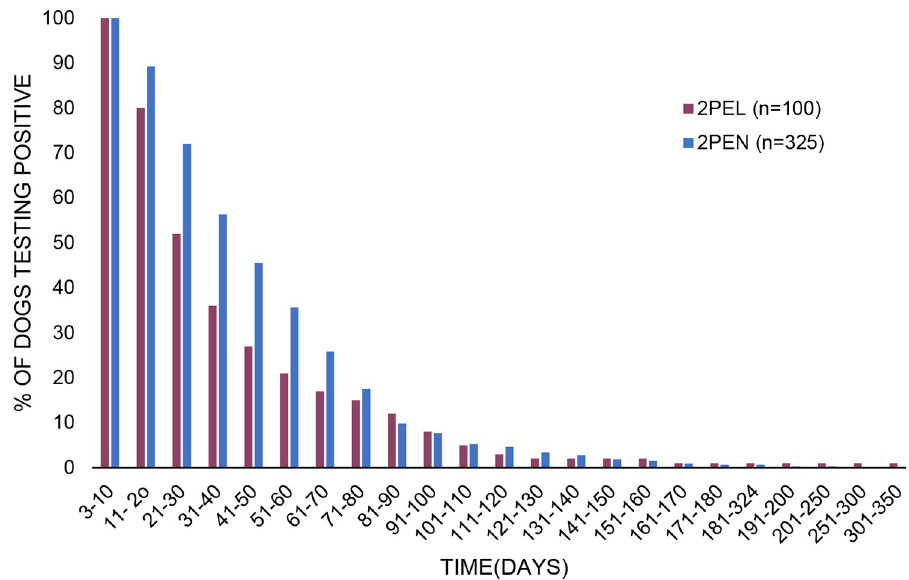
Fig 2. Duration of excretion of CDV RNA over time in 2PEL and 2PEN dogs. 2PEL (n = 100) indicates those dogs that had at least two positive results and were eventually lost to follow-up. 2PEN (n = 325) indicates those dogs that had at least two positive results and eventually tested negative. Samples were collected by swabbing the inside of one or both nares and/or the deep pharyngeal region.